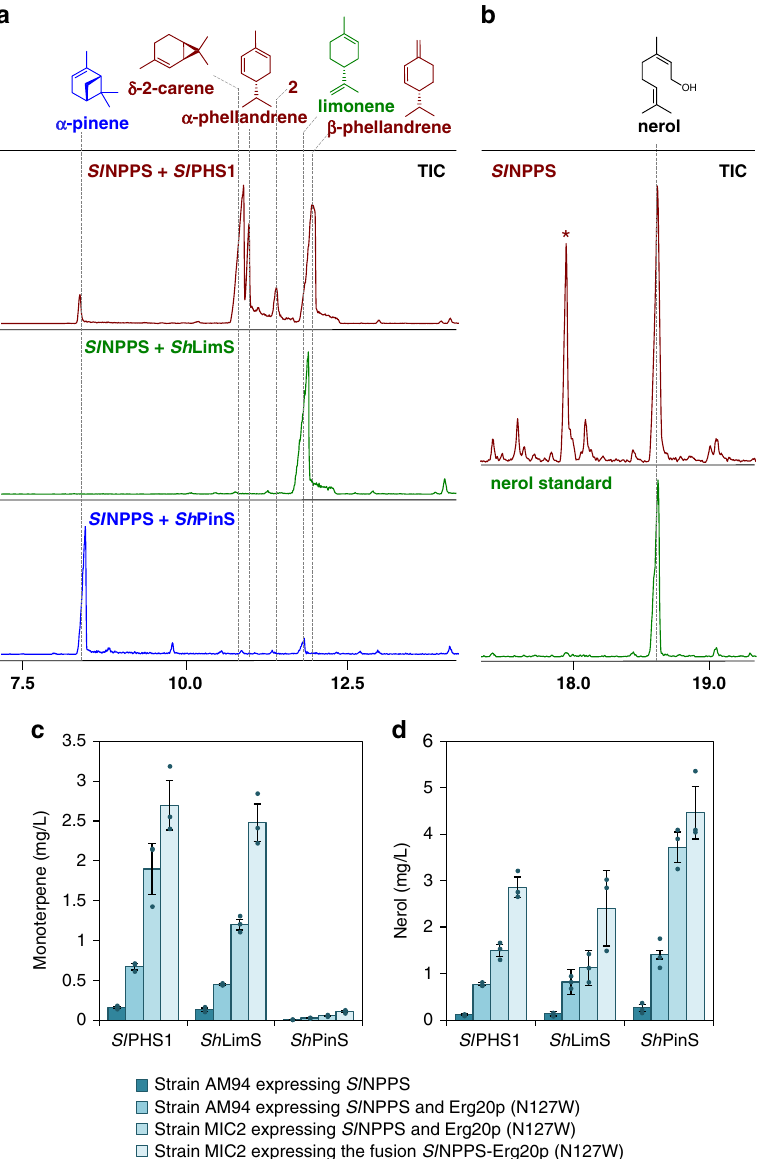
Fig. 2 Engineering NPP production in yeast. a Three NPP-speci fi c monoterpene synthases were co-expressed in yeast with Sl NPPS1. Sl PHS1 (brown) produced a mixture of monoterpenes, including β -phellandrene, δ -2-carene, α -phellandrene, and α -terpinene. Sh LimS (green) produced exclusively limonene, while Sh PinS (blue) synthesized α -pinene as the main product, together with low amounts of limonene. b Production of nerol by yeast cells (brown), presumably resulting from the hydrolysis of excess NPP. The peak marked with a star (*) corresponds to a non-terpene yeast-derived compound. The nerol standard is shown in green. c Stepwise engineering of NPP production in yeast was monitored by measurement of the monoterpene products synthesized by the three NPP-speci fi c synthases. d Production of the nonspeci fi c monoterpene product nerol by the engineered cells increased as monoterpene yields improved, suggesting that the selected NPP-speci fi c synthases could not fully harvest the NPP fl ux. Error bars correspond to the mean absolute deviation (MAD) around the mean ( n = 3, corresponding to three separate yeast transformations processed and analyzed independently). Source data of c and d are provided as a Source Data fi